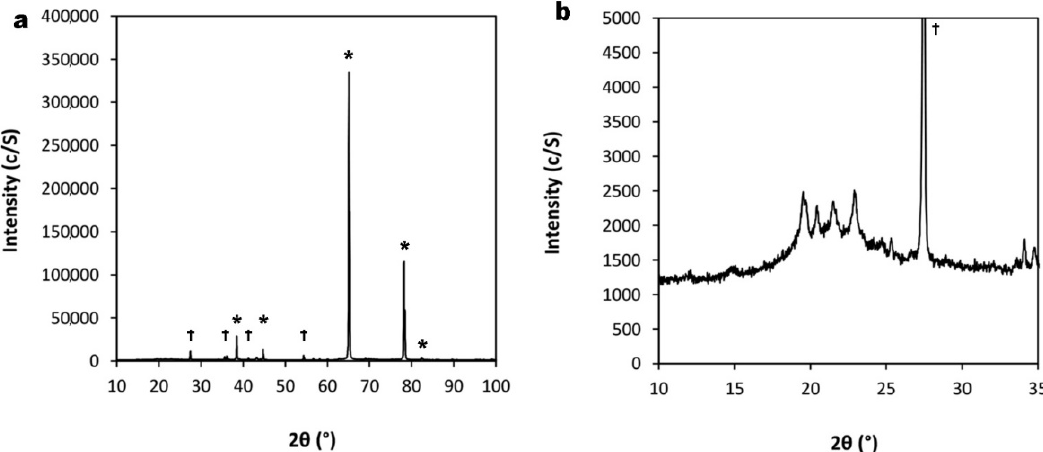
Figure 2. ( a ) XRD of the coating after 900 s of EDP, revealing two phases assigned to the Al (*) substrate and TiO 2 ( † ). ( b ) Detailed area of the XRD showing the quasi-crystalline phase assigned to zinc laurate.